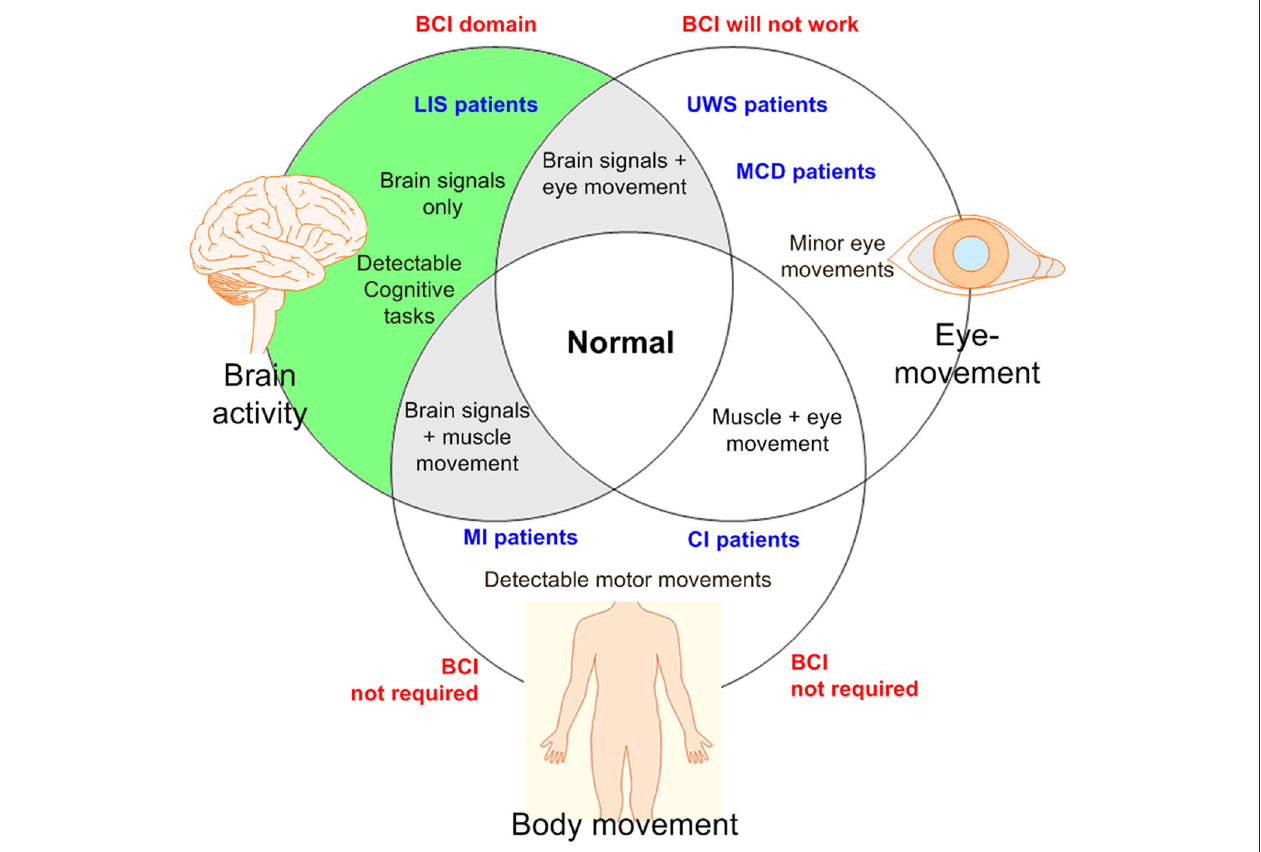
FIGURE 2 | An illustration for BCI domain: BCI is required if there is no detectable muscular movement (BCI, brain-computer interface; LIS, locked-in syndrome; UWS, unresponsive wakeful state; MCD, minimal conscious disorder; MI, motor impairment; CI, cognitive